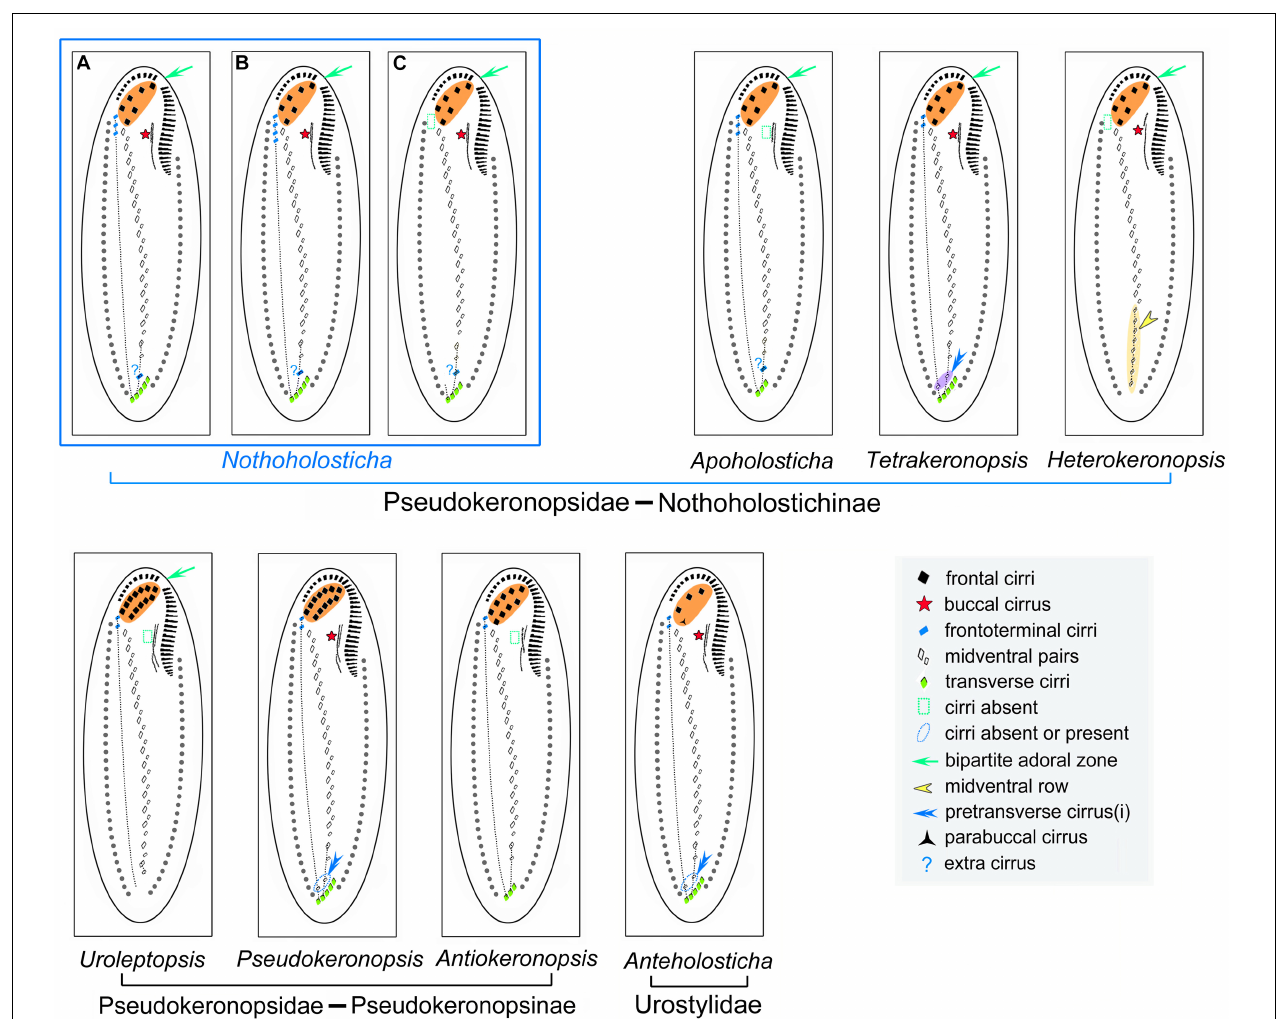
FIGURE 9 | Comparison of cirral patterns of some related urostylid genera. Cirri originating from the two rightmost (rearmost) frontal-midventral-transverse anlagen are connected by a dotted line. (A) N. luporinii n. sp. (B) N. flava . (C) N. fasciola . Note that the “extra” cirrus is regarded as a pretransverse cirrus in N. luporinii (A) , while as a midventral cirrus in the two remaining Nothoholosticha species (B,C)